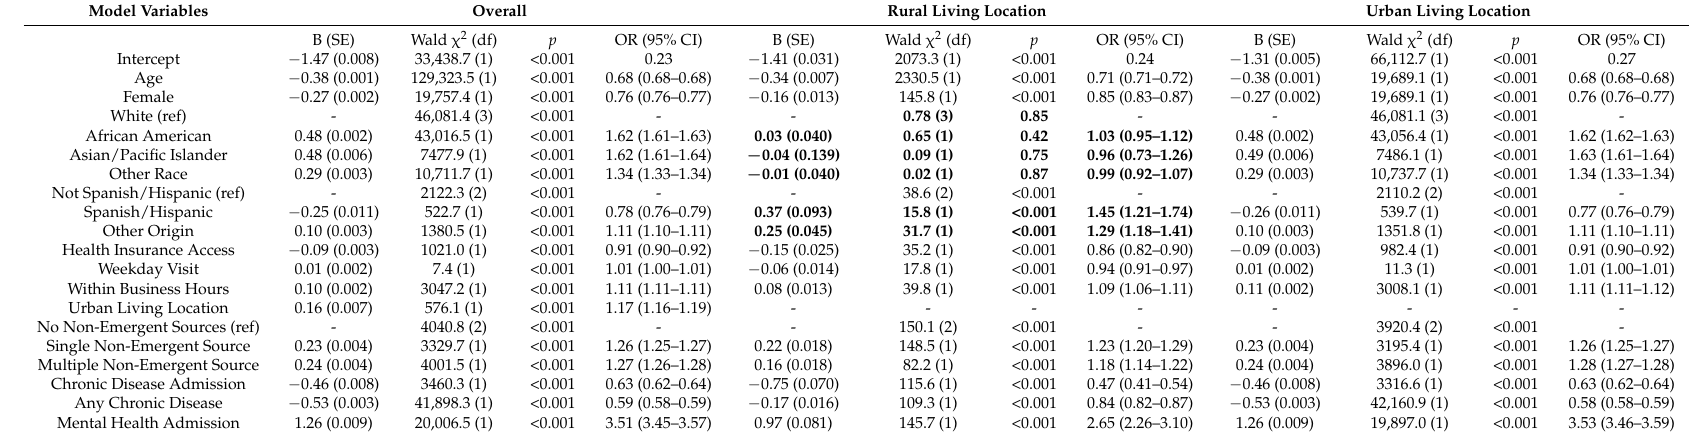
Table 2. Overall emergency department use compared to rural and urban living location emergency department use. Model